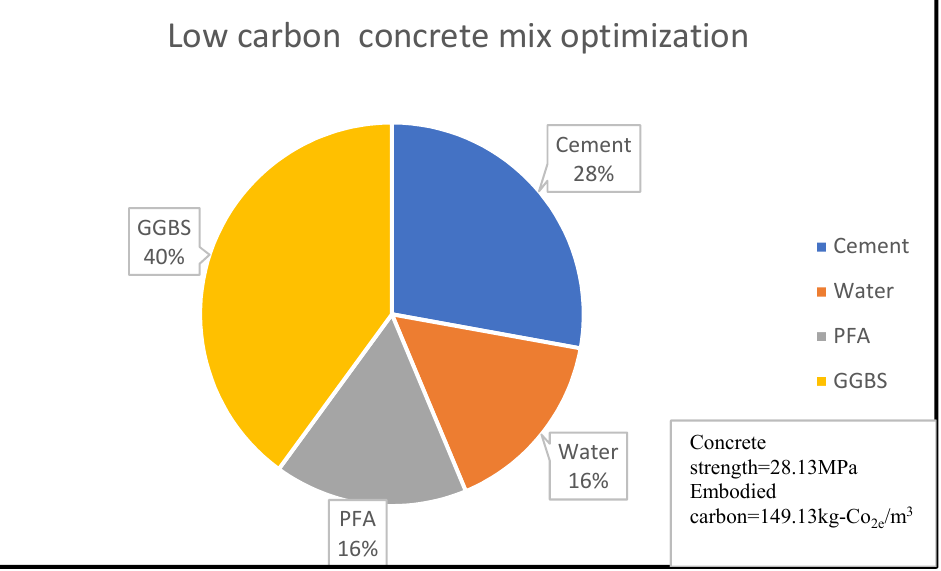
Figure 5 . LCC constituent material at water content of 16% for Concrete Batch A [32]. Figure 5. LCC constituent material at water content of 16% for Concrete Batch A Table 13. Concrete mix optimisation extracted from Concrete Batch B [32].